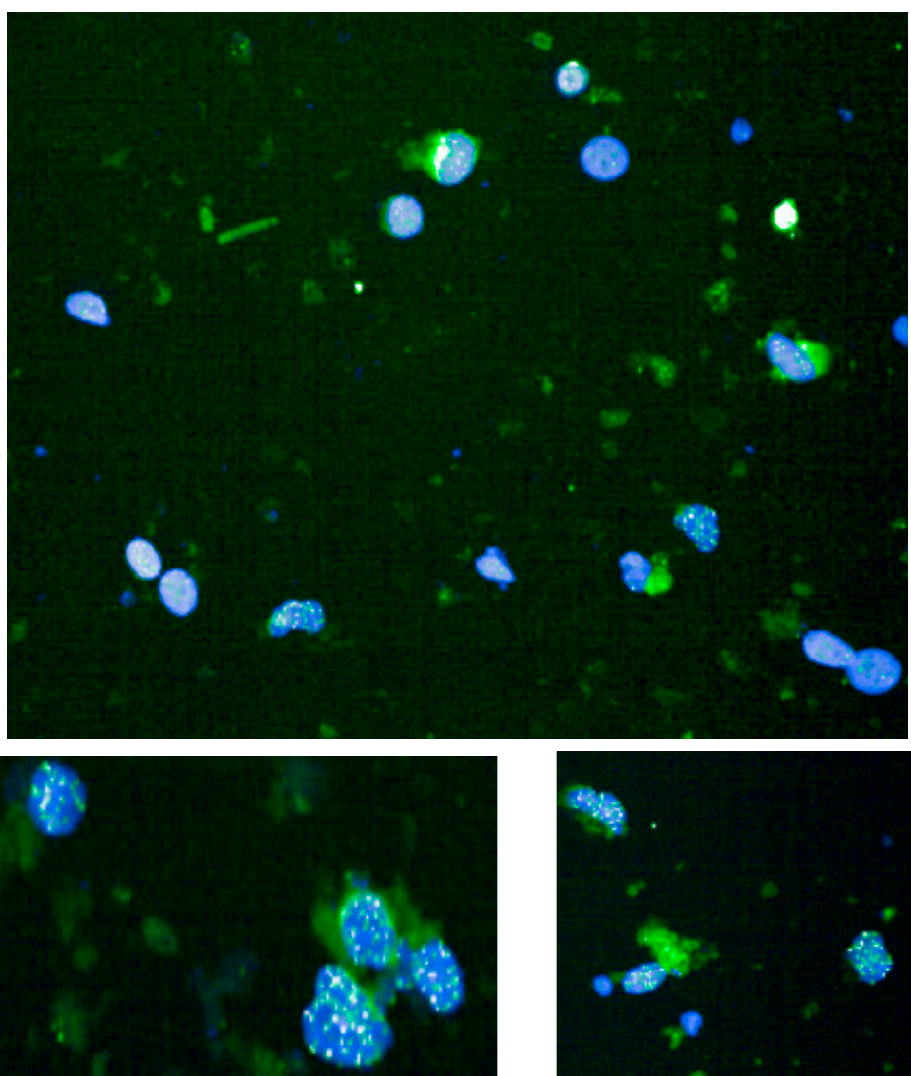
Figure 1. Representative TAT images. Both the DAPI-stained nuclei (blue) and the fluorescently labeled telomeric spots (white spots) inside each nucleus can be seen in the images below. The cells were obtained from the corresponding tissue samples of the study participants.